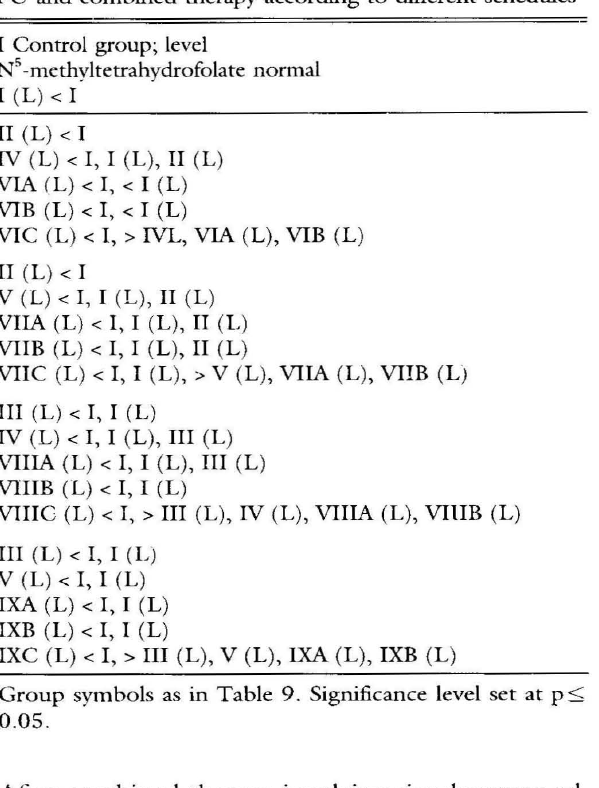
MTHF levels obtained in the:: group of healthy an imals (Table